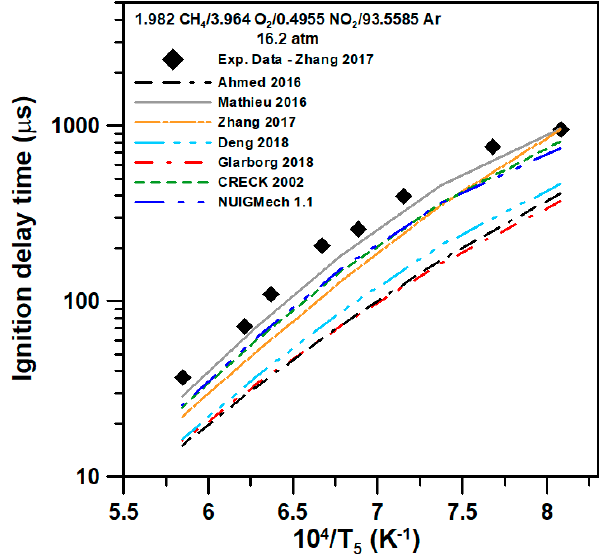
Figure 2. Comparison of ignition delay time measurements from Zhang et al. [26] with predictions from literature models.